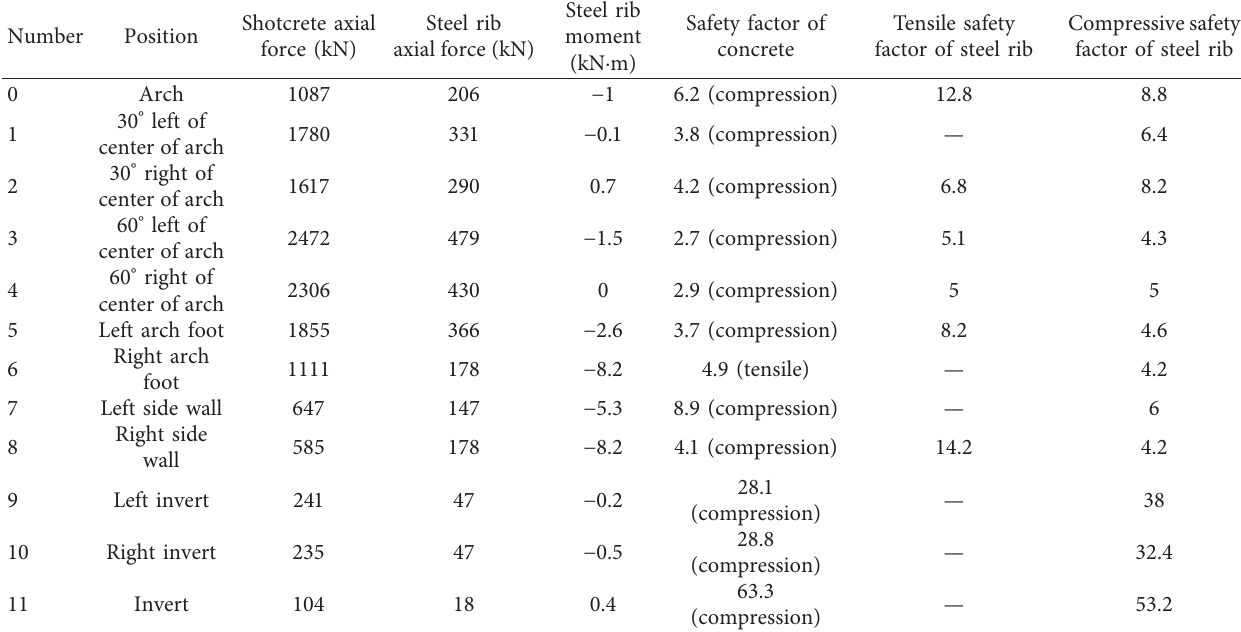
Table 3: Primary supporting internal force and material safety factor.